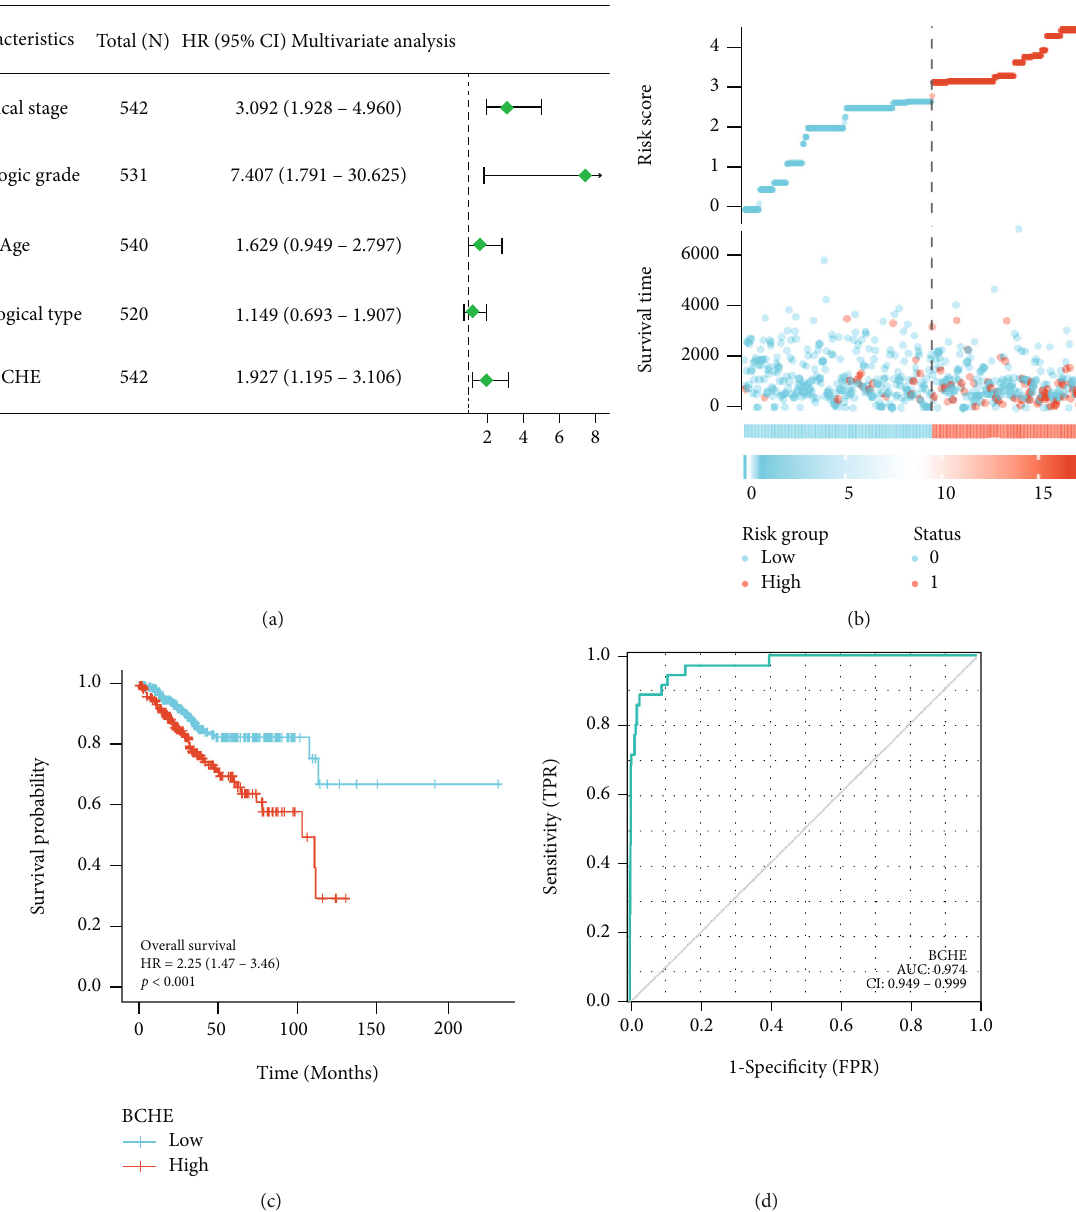
Figure 3: Survival analysis of BCHE expression. (a) Multivariate Cox analysis of BCHE expression and other clinicopathological variables. (b) BCHE expression distribution and survival status ( 0 = alive ; 1 = death ). (c) Levels of BCHE mRNA expression and overall survival. (d) ROC curves of